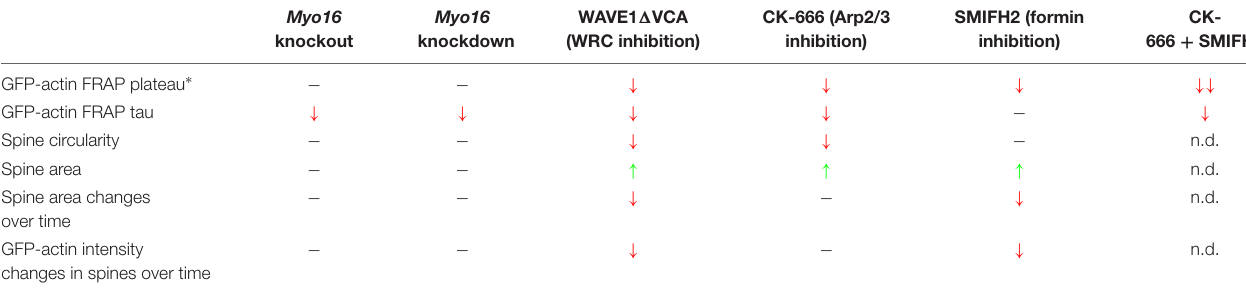
∗ Red arrows indicate significant decrease relative to control; green arrows indicate significant increase relative to control; black line indicates no change; n.d., not determined.